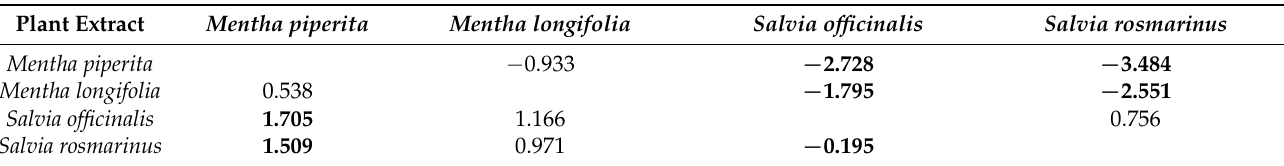
Table 3. Relative susceptibilities of Aphis punicae imago and 3rd instar of Coccinella undecimpunctata larvae to the tested four plant essential